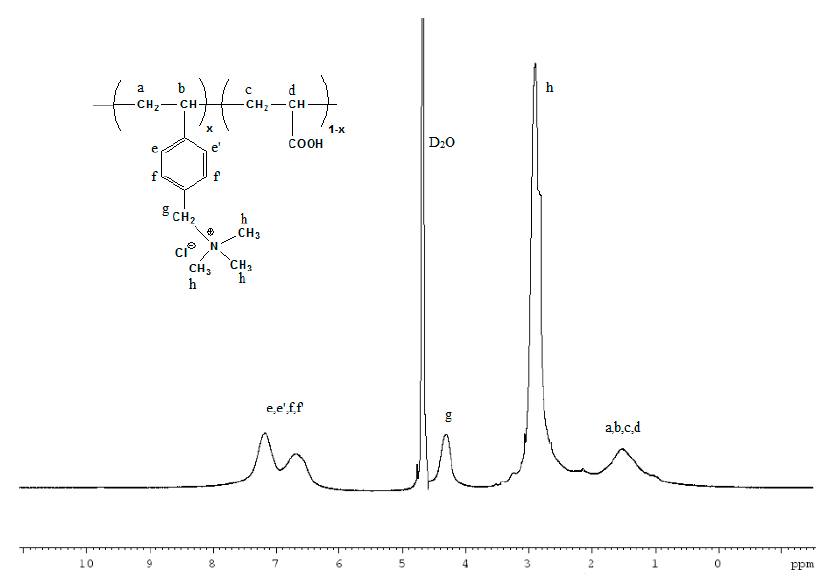
Figure 1. Proton Nuclear Magnetic Resonance ( 1 H NMR) spectrum of the quaternized P(VBCTMAM- co-AA20) copolymer in D 2 O.